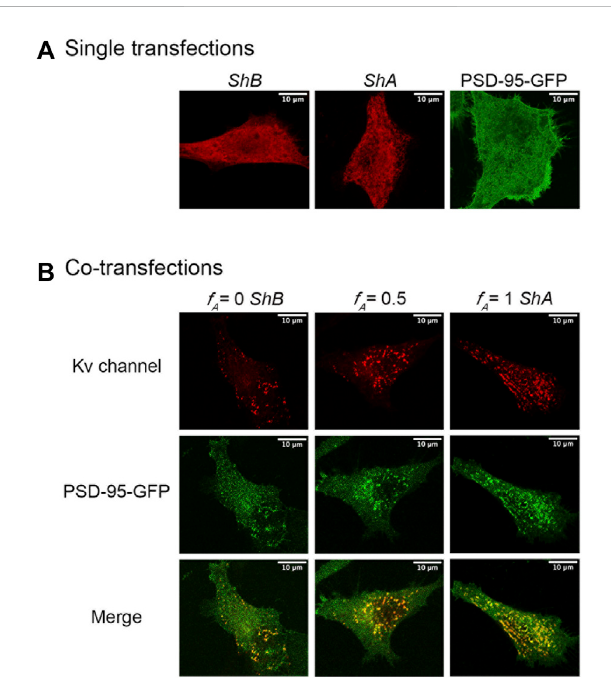
FIGURE 4 Confocal microscopy imaging of cellular Kv channel clustering. (A) High-resolution confocal microscopy images of SH-SY5Y cells expressing either the native Shaker A or B Kv channel variants alone or with the PSD-95-GFP scaffold protein partner (see Materials and Methods). (B) Typical images of cells co-expressing either the A or B native channel variants or a 1:1 combination thereof and PSD-95-GFP are shown in the left, right and middle columns, respectively. Three images are shown for each cell, with the red channel-associated fl uorescent signal shown in the top row, the green PSD-95-associated signal presented in the middle row, and the merged image shown in the bottom row. Typical triplicate images of cells transfected to express different A : B subunit DNA concentration ratios are shown in Supplementary Figure S2. Acquisition conditions for all samples were identical (see Materials and Methods). Note that under these conditions, it is the membrane surface of the cells that is imaged and so the nucleus isnotseen.Whenthecellisimagedattheequatorialplanecrosssection, thenucleusisvisibleandexhibitsrim fl uorescence,re fl ectingKvchannel accumulation atthemembrane ofthenucleus (notshown).Scale barsin panels a and b and in all images presented in Supplementary Figure S2 correspond to 10 μ